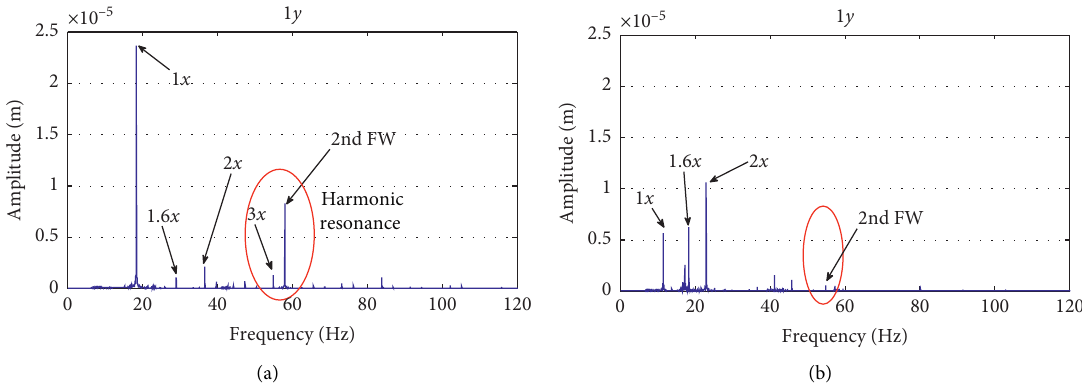
Figure 26: Spectrum of misalignment and unbalance at bearing 1: (a) horizontal ( Ω Ω 2 �